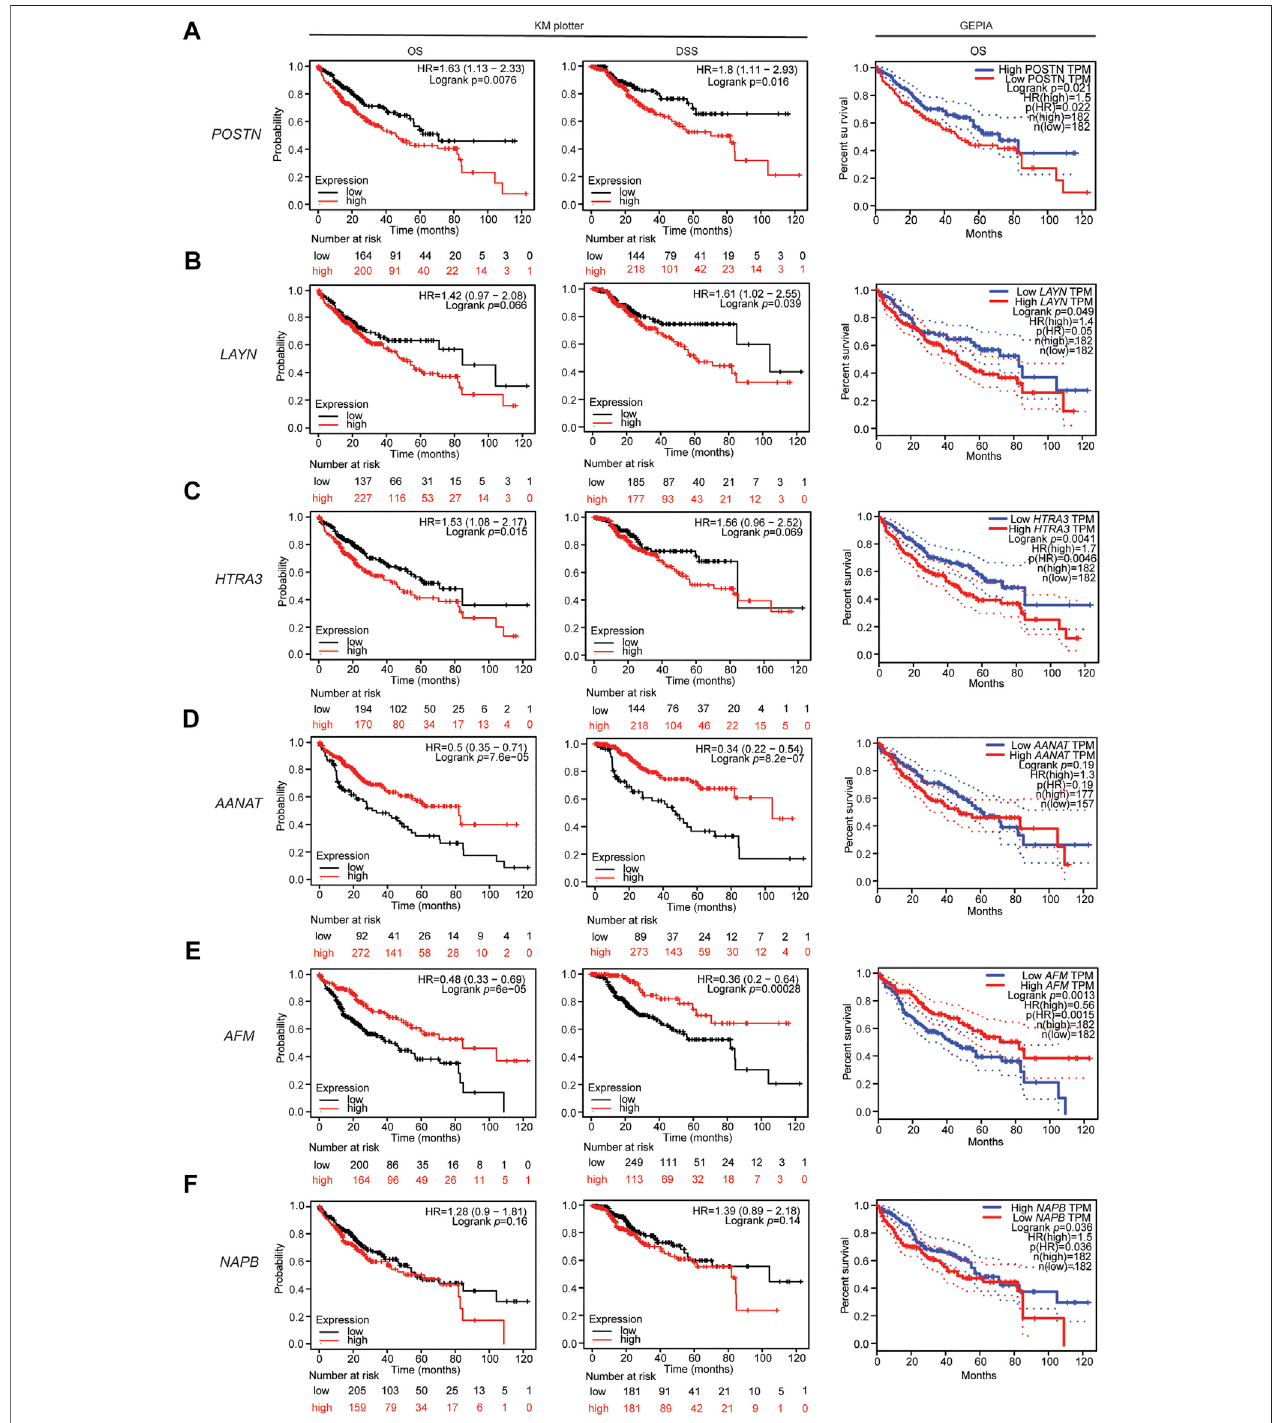
FIGURE 3 | Associations between the DEGs and patient outcomes in liver cancer. Overall survival curve for patients with liver cancer in the GEPIA database (right) and overall survival and disease speci fi c survival curves (left, center) for patients with liver cancer in the Kaplan-Meier plotter databases strati fi ed by expression of (A) POSTN , (B) LAYN , (C) HTRA3 , (D) AANAT , (E) AFM , and (F) NAPB .